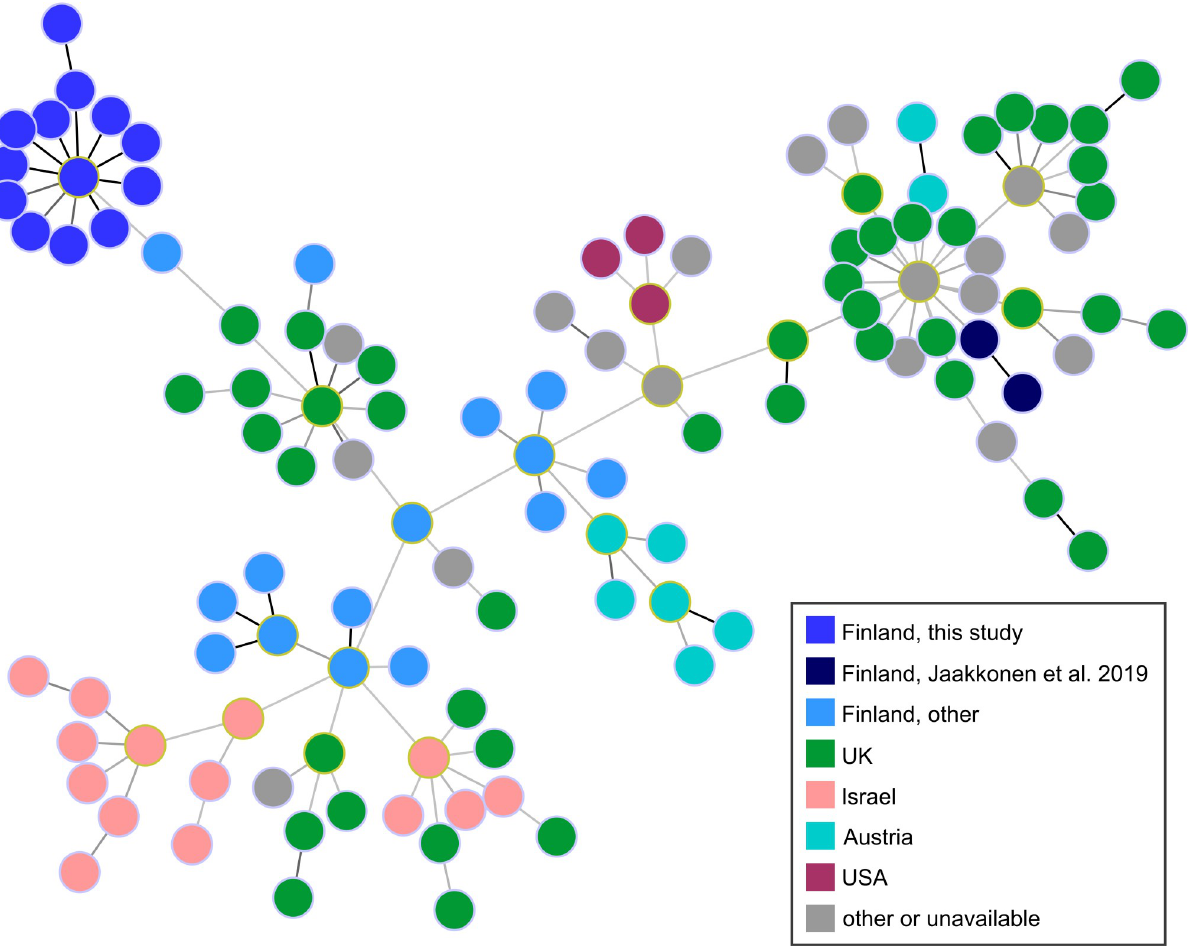
Fig 1. Minimum spanning tree from wgMLST comparison of ST-883 C . jejuni isolates. Dairy farm isolates from this study (n = 40) are compared with globally collected ST-883 isolates (n = 137), including dairy farm isolates from Jaakkonen et al. [11]. Nodes are colored by country. Black and dark gray links indicate short allelic distances of 1 and 2 loci, respectively, in the profile size of 718 loci.